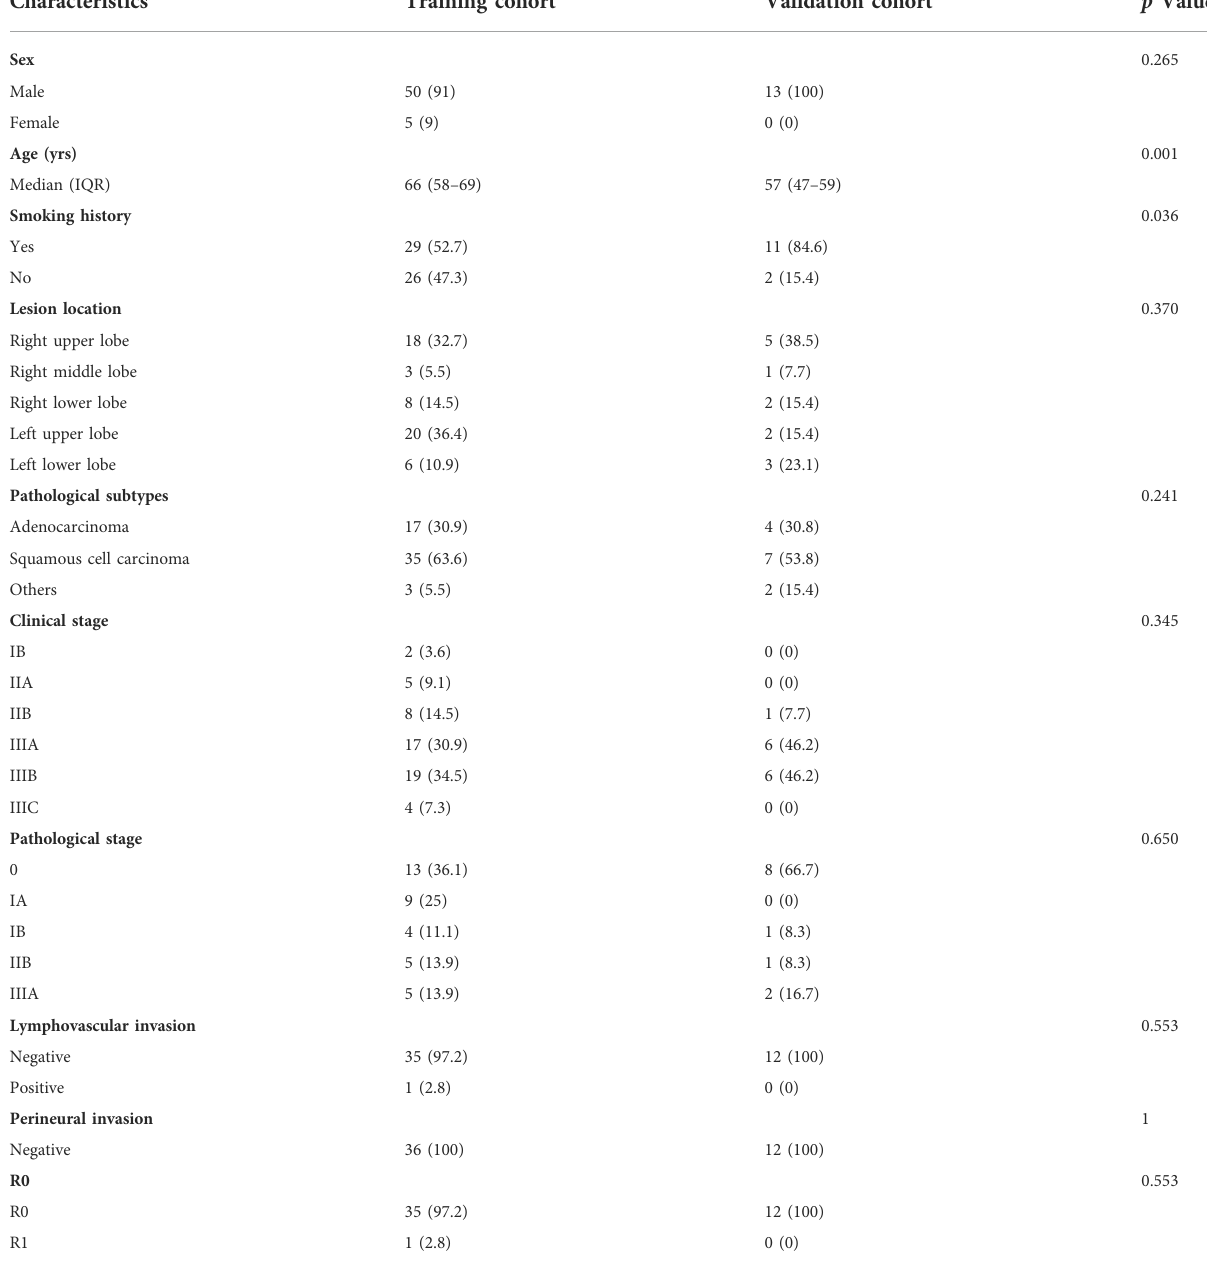
TABLE 1 Patient characteristics. Values are presented as n (%) or median (interquartile